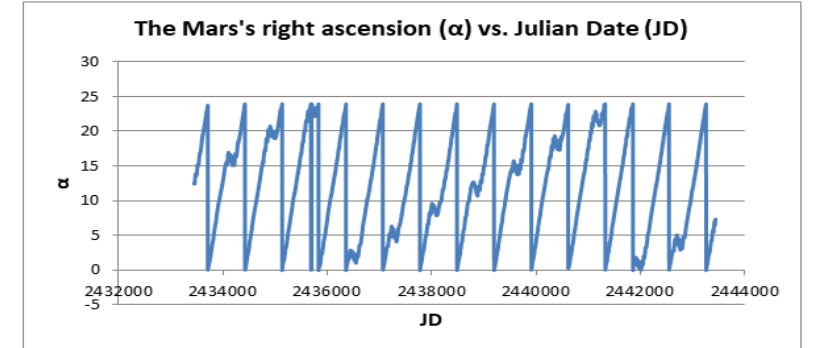
Figure 3: The change of the Mars right ascension with Julia date during 10000 days .